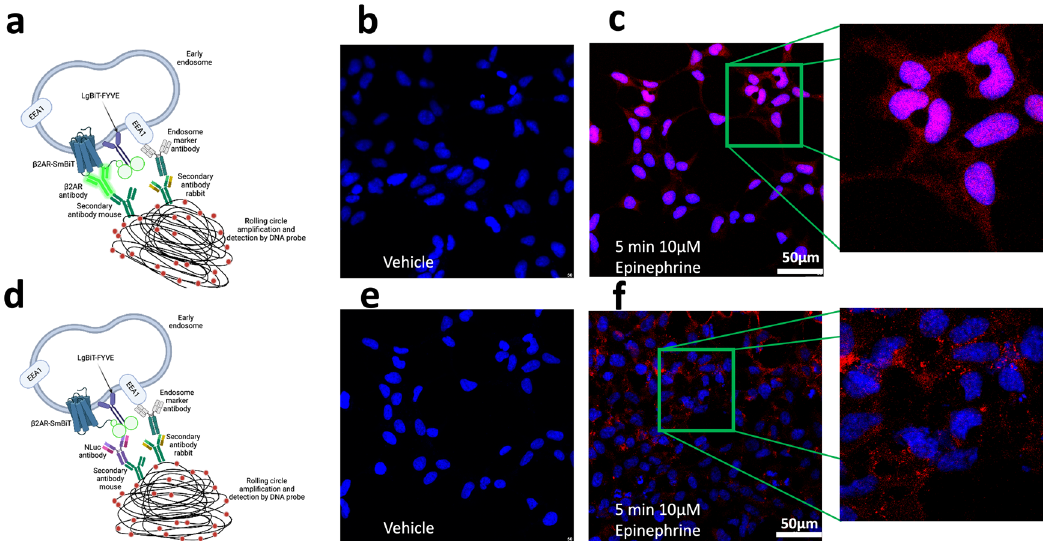
Fig. 3 Schematic of the Proximity Ligation Assay (PLA). Two primary antibodies recognize speci fi c proteins in the cell: a β 2AR-SmBiT and Early Endosome Antigen 1 (EEA1). d LgBiT-FYVE and Early Endosome Antigen 1. In both cases, secondary antibodies coupled with oligonucleotides (PLA probes) bind to